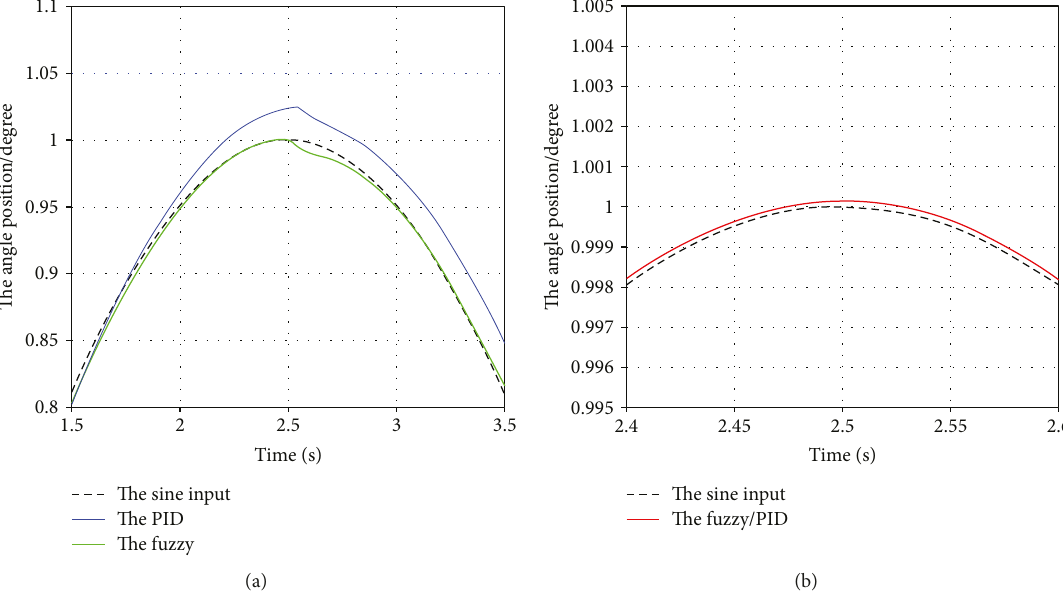
Figure 13: The comparison of system responses to sine input among di ff erent methods under the friction disturbance: (a) PID and fuzzy controller and (b) fuzzy/PID compound controller.